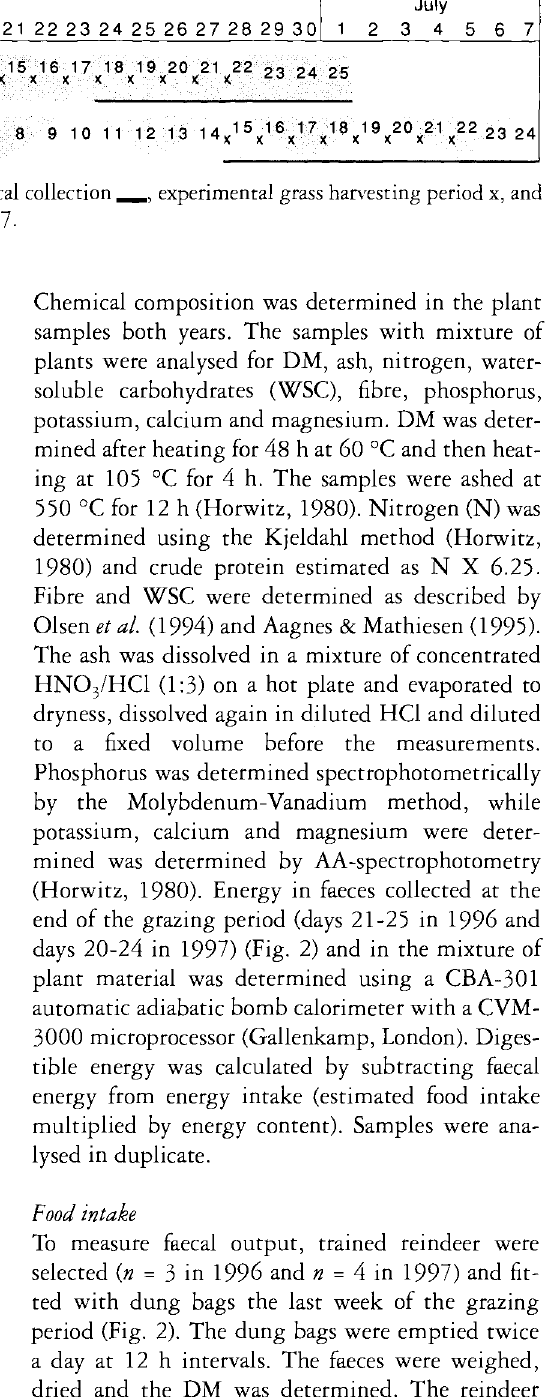
Fig. 2. Length and date for grazing , snow melt *, faecal collection experimental grass harvesting period x, and day no. 1 in the grazing periods for 1996 and